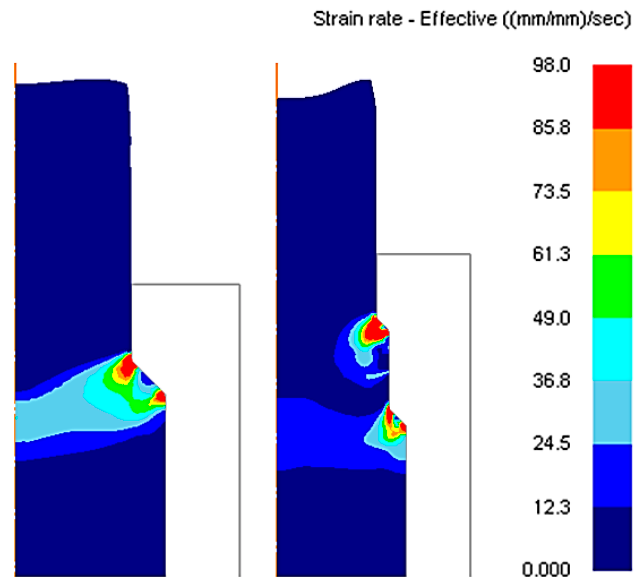
Figure 1. Scheme of single and double-pass extrusions showing strain rate contour diagrams by FEA (finite element analysis).